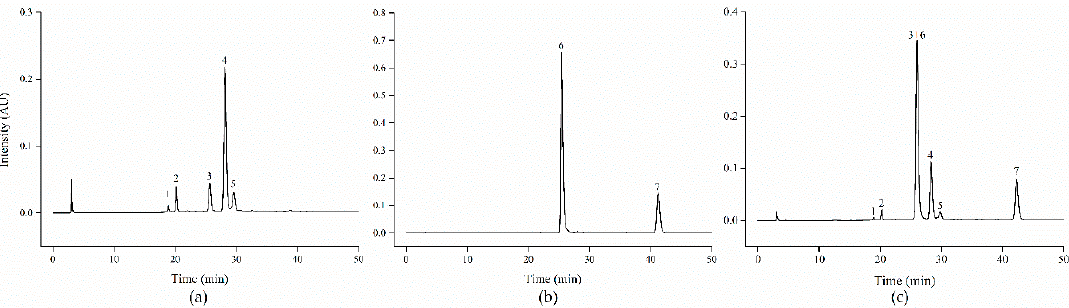
Figure 2. HPLC separation of anthocyanins (520 nm) from a black carrot extract ( a ) strawberry extract ( b ) and their mixture (1:1, v : v ) ( c ). For peak assignment see Table 1. Figure 2c show the HPLC-DAD chromatogram of the black carrot and strawberry